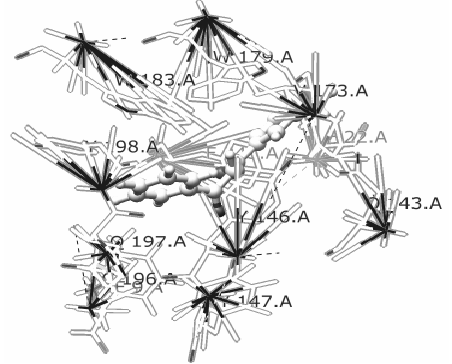
Figure 7. 1a docked in the active site of